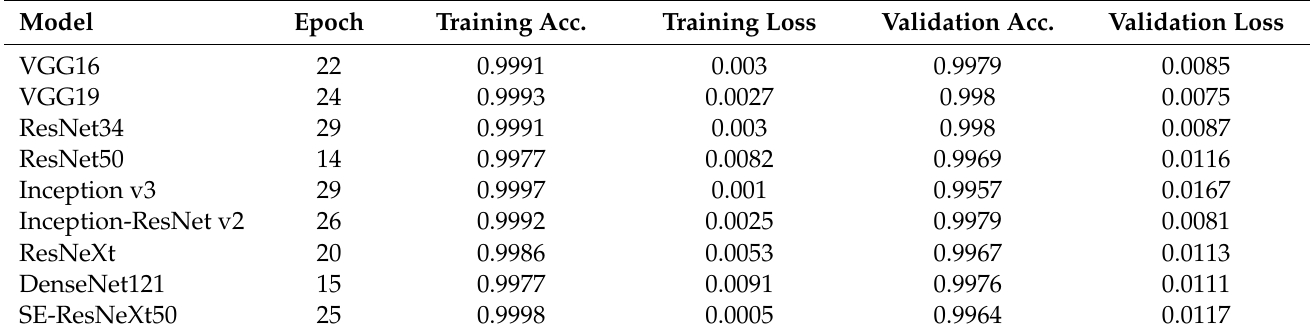
Table A1. Accuracy statistics and epochs of final segmentation maps per model. The epoch with the highest validation accuracy was chosen as a representation for each model. Accuracy and loss values were rounded to the fourth decimal